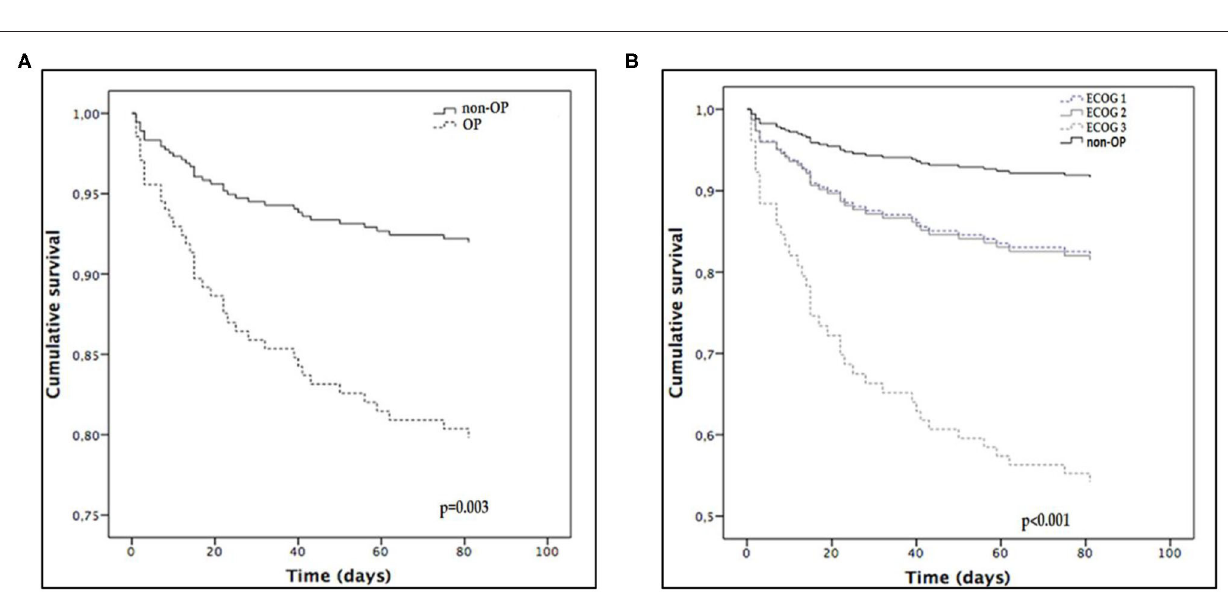
FIGURE 3 | Adjusted survival curves where OP is oncological patients. (A) non-OP vs. OP; (B) non-OP (as reference) and OP categorized according to ECOG performance status. ECOG, East cooperative oncology